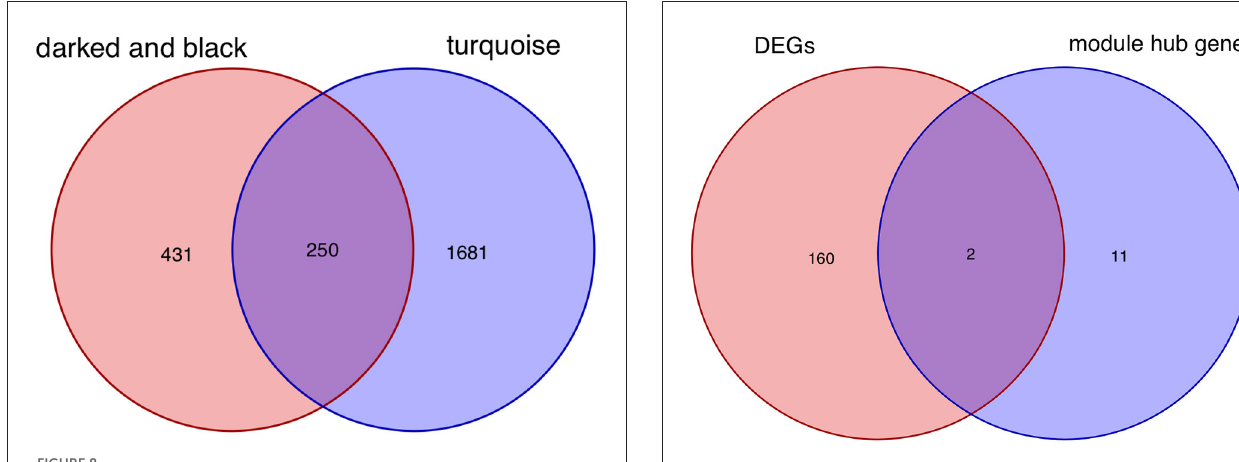
FIGURE10 Intersecting genes of DEGs and module hub genes. Red and purple represent DEGs and module hub genes, respectively. DEGs, differentially expressed genes.